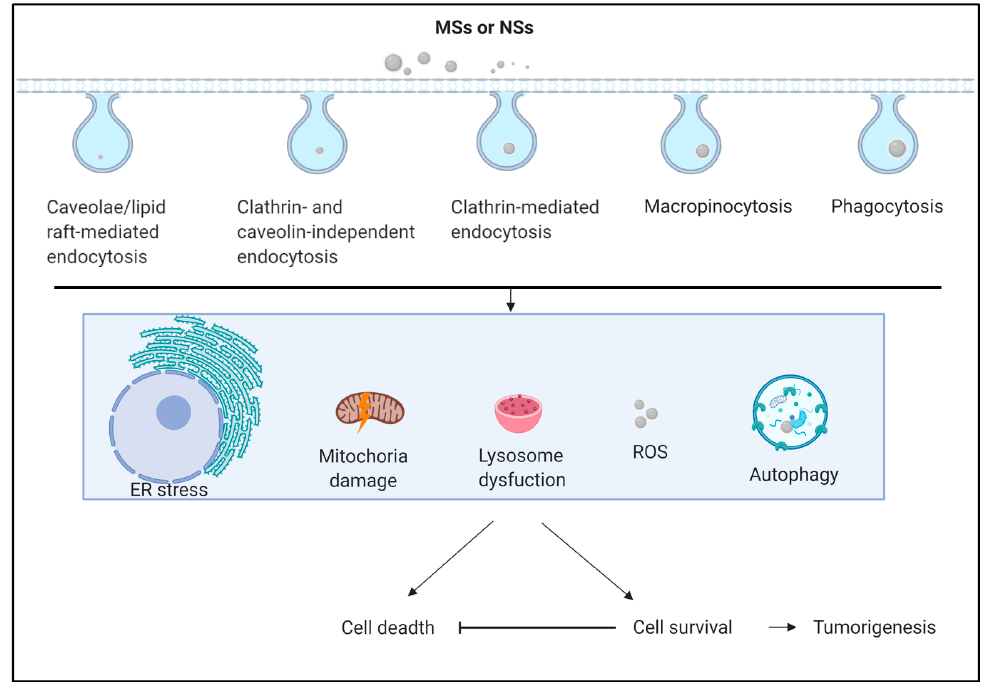
Figure 1. Schematic picture of several major endocytosis pathways for micro- and nanosized substances (MSs and NSs). MSs and NSs employ one or multiple endocytosis pathways to enter cells. The main endocytosis pathways of MSs or NSs include clathrin-mediated endocytosis, caveolae/lipid raft-mediated endocytosis, clathrin- and caveolin-independent endocytosis, macropinocytosis and phagocytosis. The possible mechanisms by which MSs and NSs modulate several cell responses, such as ER-stress, mitochondrial damage, lysosome dysfunction, ROS production, and autophagy, are summarized. MSs: Micro-sized substances; NSs: Nanosized substances.Extracellular vesicles (EVs) are defined as lipid-bound particles of various sizes secreted from cells to extracellular spaces or circulated to target tissues [69,70]. EVs can be briefly classify into three types based on their size and biogenesis [71,72]. Small EVs are 50–100 nm in size and, include exosomes and endosome-derived membrane vesicles that are formed from multivesicular bodies (MVBs), intraluminal vesicles (ILVs) and the cellular plasma membrane [73,74]. Microvesicles (MVs), microparticles (MPs) and ectosomes are considered large EVs that are shed directly from the cell surface [73,75]; apoptotic bodies are formed during apoptosis genesis, and